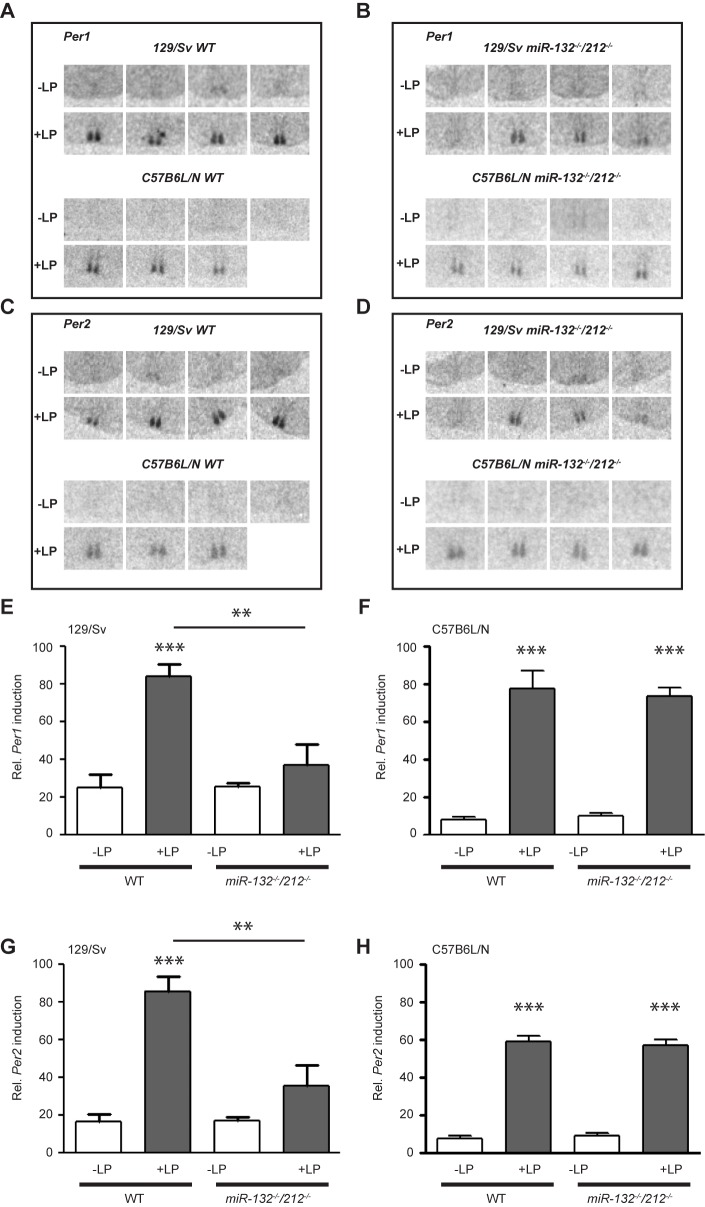
Light induced Per gene expression.Light induced Per1 (A, B) and Per 2 expression (C, D) in the SCN of individual WT (A, C) and KO (B, D) mice in 129/Sv and C57Bl/6N backgrounds after a light pulse (100 lx, 1 h) at CT15 as shown by in situ hybridization. (E-H) Quantification of Per1 (E, F) and Per2 (G, H) mRNA levels in the SCN of WT or KO mice measured by radio-labelled ISH. Per1: 129/Sv: -LP: 25.2 +/- 7; +LP: 83.8 +/- 6.6; KO: -LP: 25.8 +/- 6.6; +LP: 25.8 +/- 2.0; C57BL/6N: -LP: 8.2 +/- 1.1; +LP: 77.5 +/- 9.4; KO: -LP: 9.8 +/- 1.5; +LP: 73.5 +/- 4.8, Per2: 129/Sv: -LP: 16.7 +/- 3.7; +LP: 85.8 +/- 7.6; KO: -LP: 17.1 +/- 2.1; +LP: 35.5 +/- 11.3; C57BL/6N: -LP: 8.9 +/- 1.3; +LP: 76.0 +/- 11.3; KO: -LP: 10.9 +/- 1.7; +LP: 80.2 +/- 5.3; n = 4. 129/Sv: -LP vs. +LP, two-way ANOV for interaction Per1: F(1. 12) = 10.48, p = 0.0071, Sidak’s post-hoc test for light conditions: WT: p < 0.001; KO: p > 0.05, Sidak’s post-hoc test for genotype: -LP: p > 0.05, +LP: p < 0.01; Per2: F(1. 12) = 12.62, p = 0.004, Sidak’s post-hoc test for light conditions: WT: p < 0.001; KO: p > 0.05, Sidak’s post-hoc test for genotype: -LP: p > 0.05, +LP: p < 0.01. C57BL/6N: -LP vs. +LP, two-way ANOVA for interaction Per1: F(1.11) = 0.4042, p = 0.5379; two-way ANOVA for light conditions F(1. 11) = 209.6, p < 0.0001; Per2: two-way ANOVA for interaction F(1.12) = 0.0327, p = 0.8595; two-way ANOVA for light conditions F(1. 12) = 116.4, p < 0.0001. Data are represented as mean ± SEM, ** p < 0.01, *** p < 0.001.